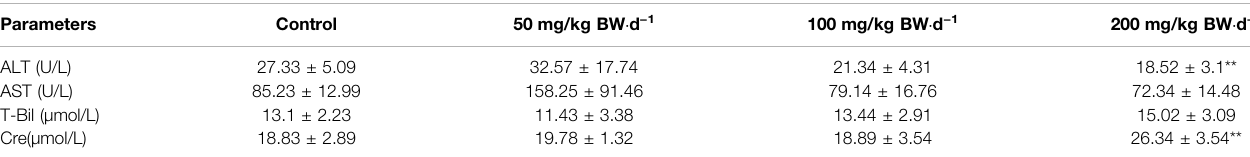
TABLE 3 | Effect of daily oral administration of jaranol on liver and kidney function in mice. Parameters